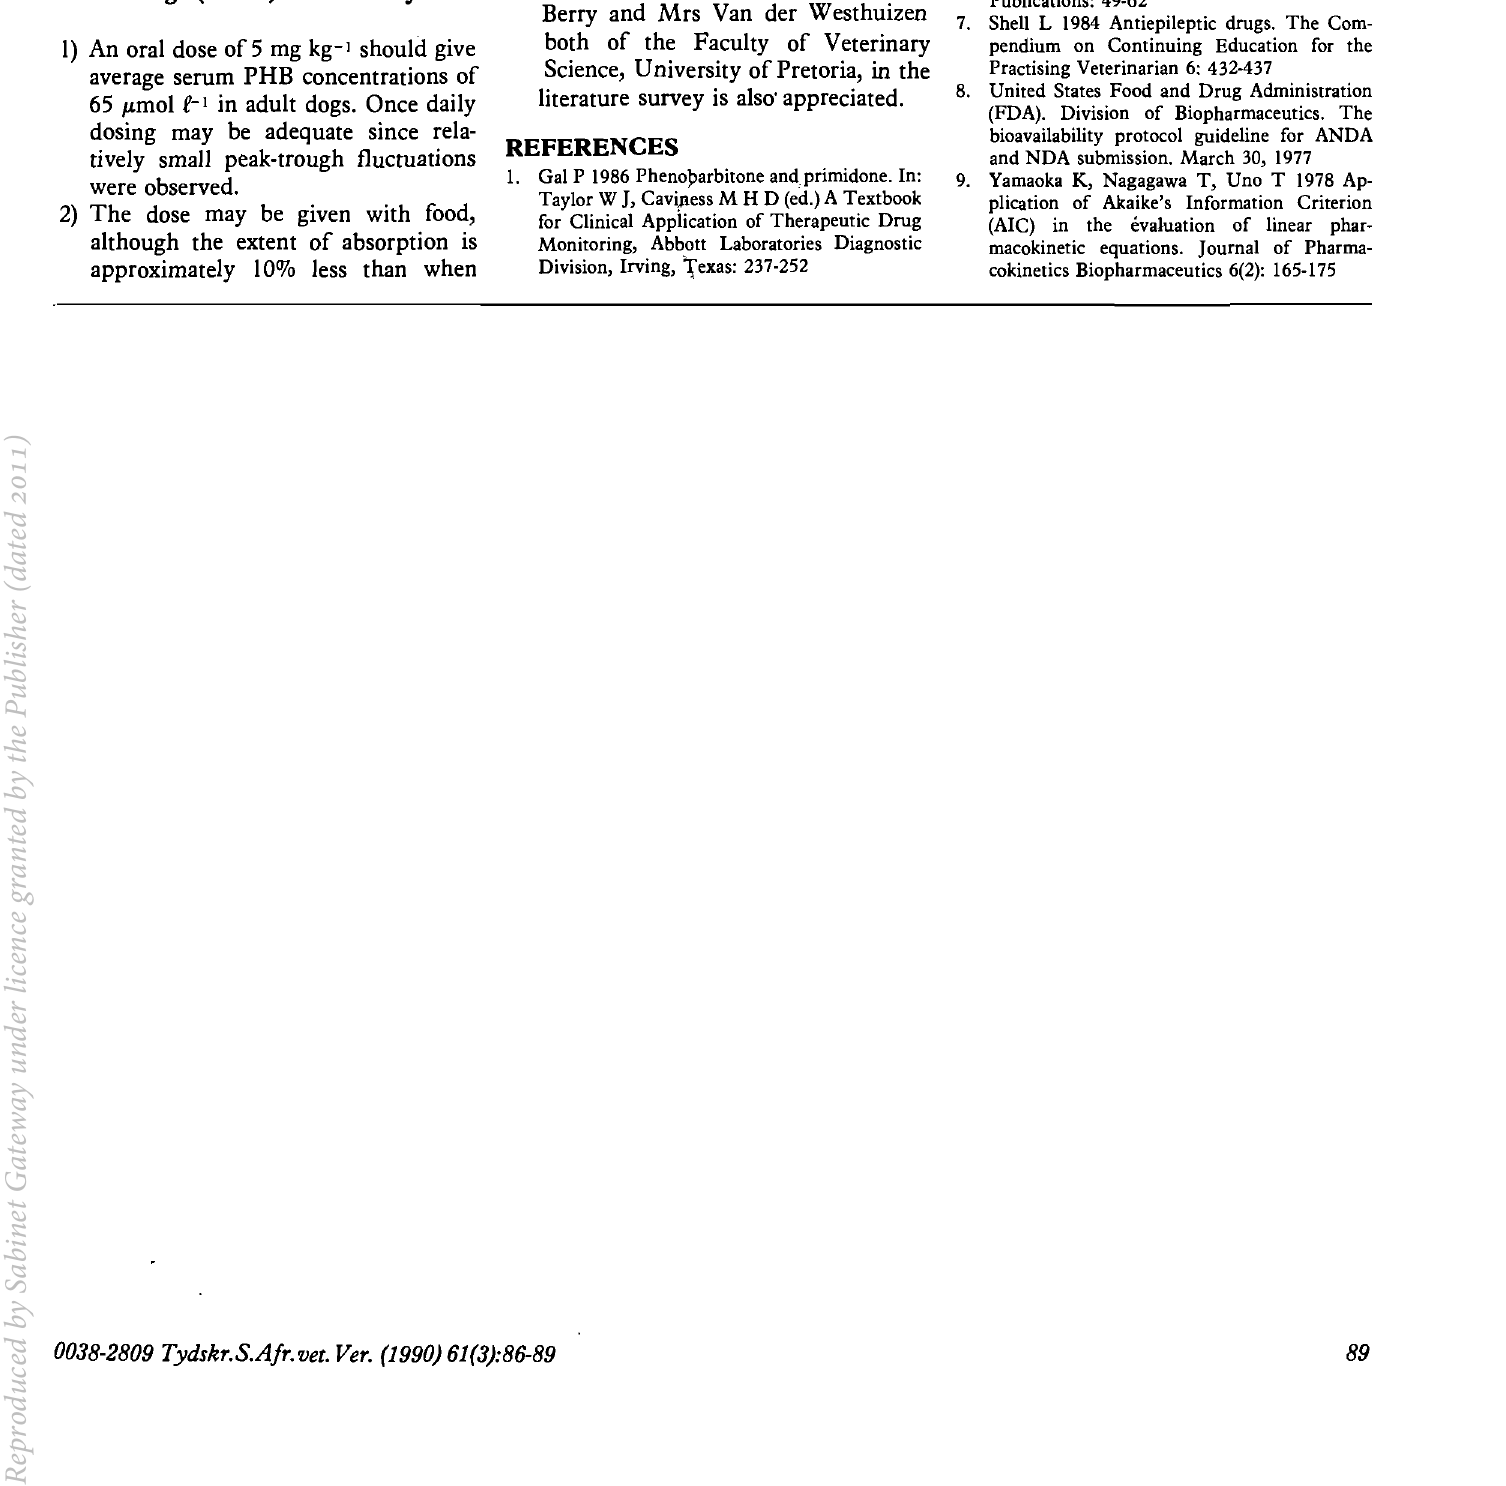
Fig. 2: Average trough serum pheno barbitone concentrations in = dogs (n 10) over 24 days I) An oral dose of 5 mg kg-I should give average serum PHB concentrations of 65 I-'mol £-1 in adult dogs. Once daily dosing may be adequate since rela tively small peak-trough fluctuations were